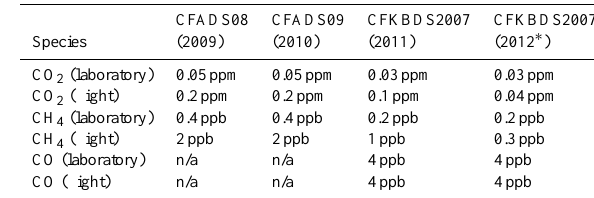
Fig. 4. Transition times between different standard gases for CO 2 (left), CH 4 (center), and water vapor (right), from a laboratory test, with parameters as they are at ACG. CO transition times were too short to be measurable within the instrument noise and are not shown. The WMO-recommended compatibility of measurements for CO 2 and for CH 4 is shown in solid black lines at 0.1ppm and 2ppb, respectively. The solid black lines on the right panel indicate 0.01%, or 100ppm H 2 O. Table 1. Typical short-term precision of Picarro CRDS analyzers at the fastest measurement frequency ( ∼ 0.5Hz). Flight condition values occur during turbulent portions of flights (i.e., low altitudes and/or altitude